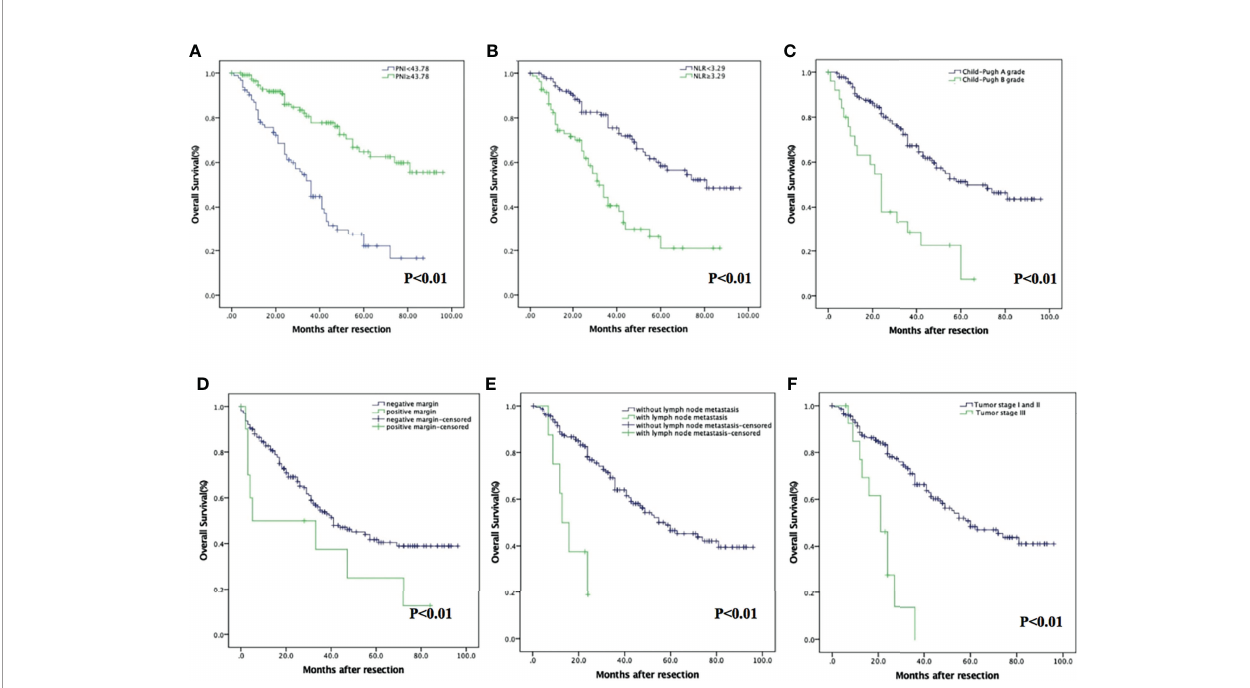
FIGURE 2 | Kaplan – Meier analysis of HCC patients showing OS curves strati fi ed according to PNI (A) , NLR (B) , Child – Pugh grade (C) , vascular invasion (D) , tumor stage (E) , and degree of differentiation (F)